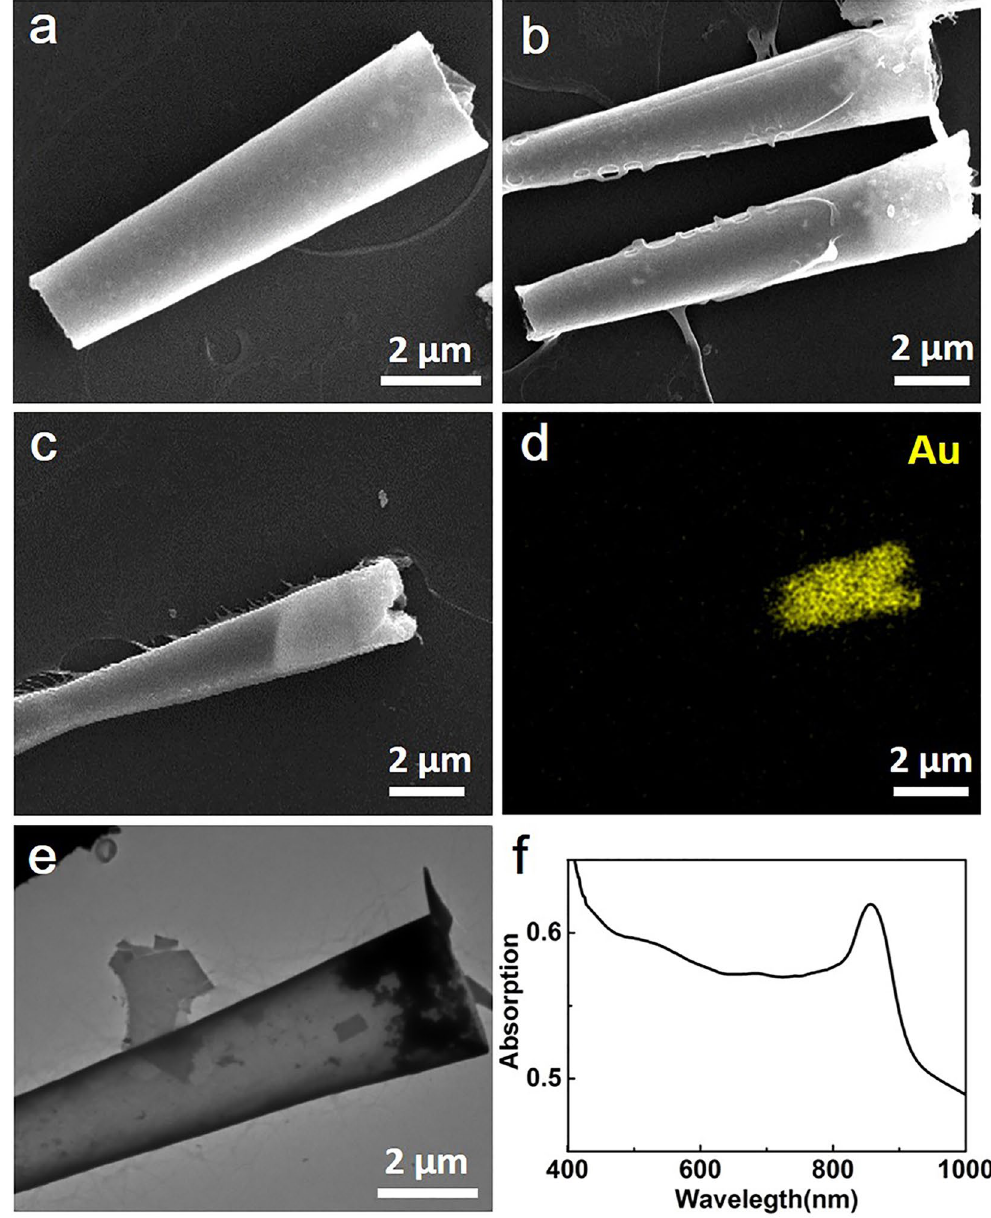
Figure 2. Characterization of the Gold Film-functionalized Torpedoes Motor. ( a ) SEM image of bare torpedoes without Au nanoparticles. ( b ) SEM image of Au-tailed torpedo. ( c , d ) SEM image of Au-tailed torpedo and its corresponding Au EDX mapping. ( e ) TEM image of Au-tailed torpedo. ( f ) UV/Vis-NIR extinction spectra of Au-tailed